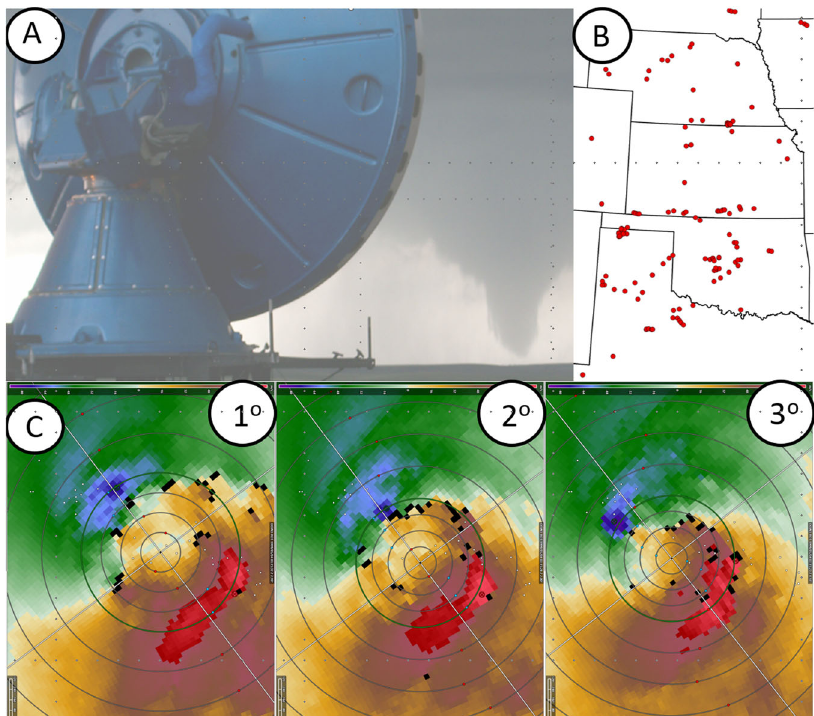
Fig. 1 DOWs observe tornado wind speeds. A DOW observing a tornado. B Map of locations of DOW-observed tornadoes 1995-2006. C Example of DOW V d fi elds observed at three levels in a tornado. Blue/red = in/outbound. Note that the peak wind speed observed at each level is not necessarily immediately above the peak observed in the next lower level.